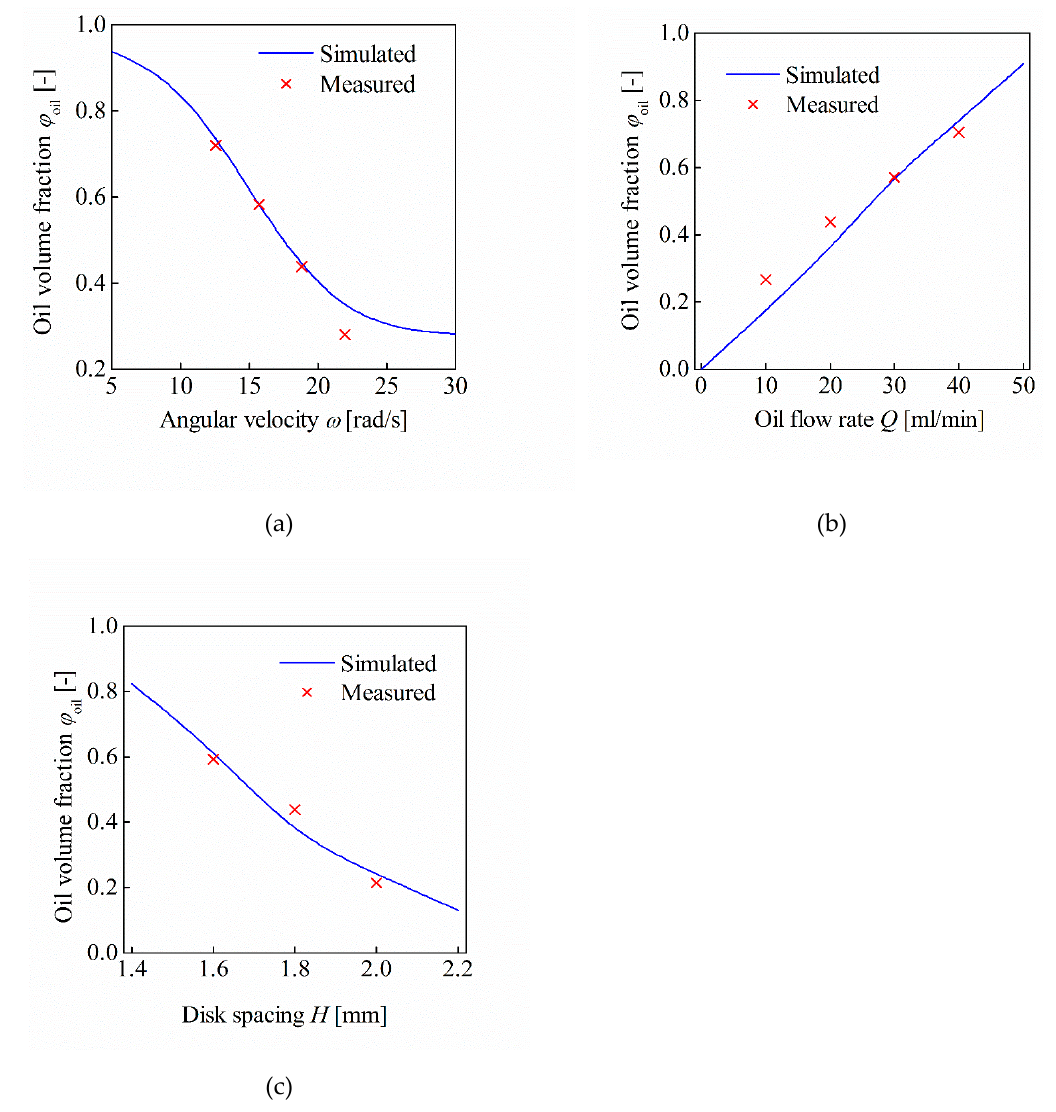
Figure 12. Parametric effects on the average oil volume fraction. ( a ) effect of the angular velocity; ( b ) effect of the inlet oil flow rate; ( c ) effect of the disk spacing.